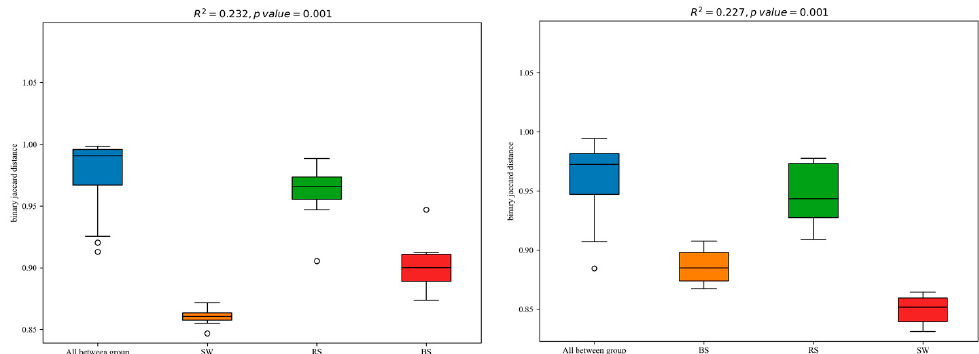
Figure 4. PERMANOVA analysis among di ff erent groups. The R -value is closer to 1, indicating that the di ff erence between groups is more signi fi cant than the di ff erence within groups; the smaller R - value indicates no signi fi cant di ff erence between and within groups. RS: the seagrass rhizosphere soil samples; BS: sediment samples; SW: seawater samples .